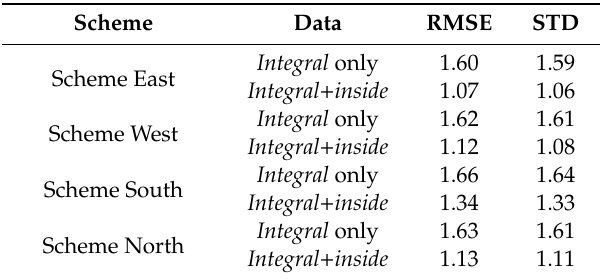
Table 4. The mean RMSE and STD for the conventional method and proposed method during the 31-day period from DOY 213 to DOY 243, 2017 (unit: g / m 3